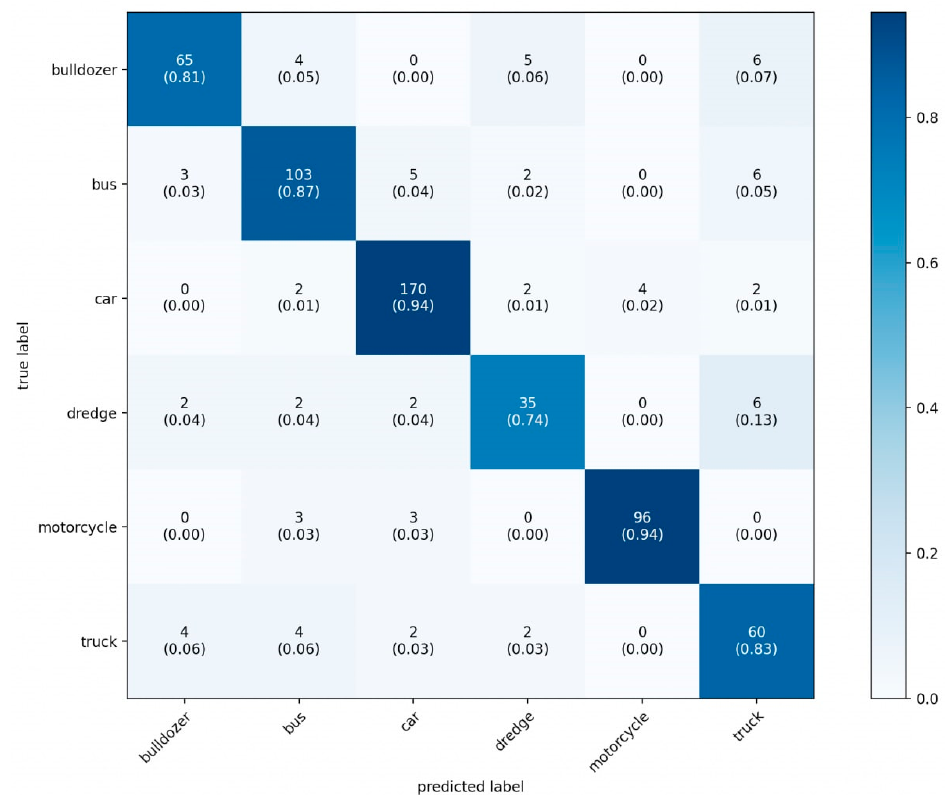
Figure 11. Visualization matrix of errors (testing sample).